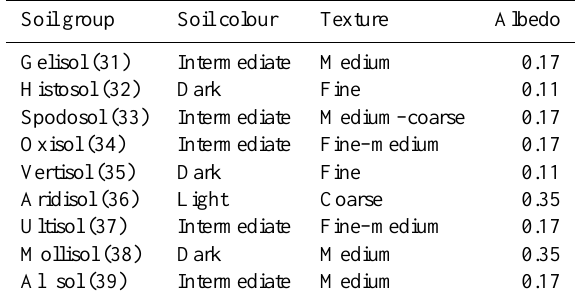
Table 2. The colour (for albedo) and texture translations for the soil orders used in the modelling of Late Pliocene soils, based upon HadCM3